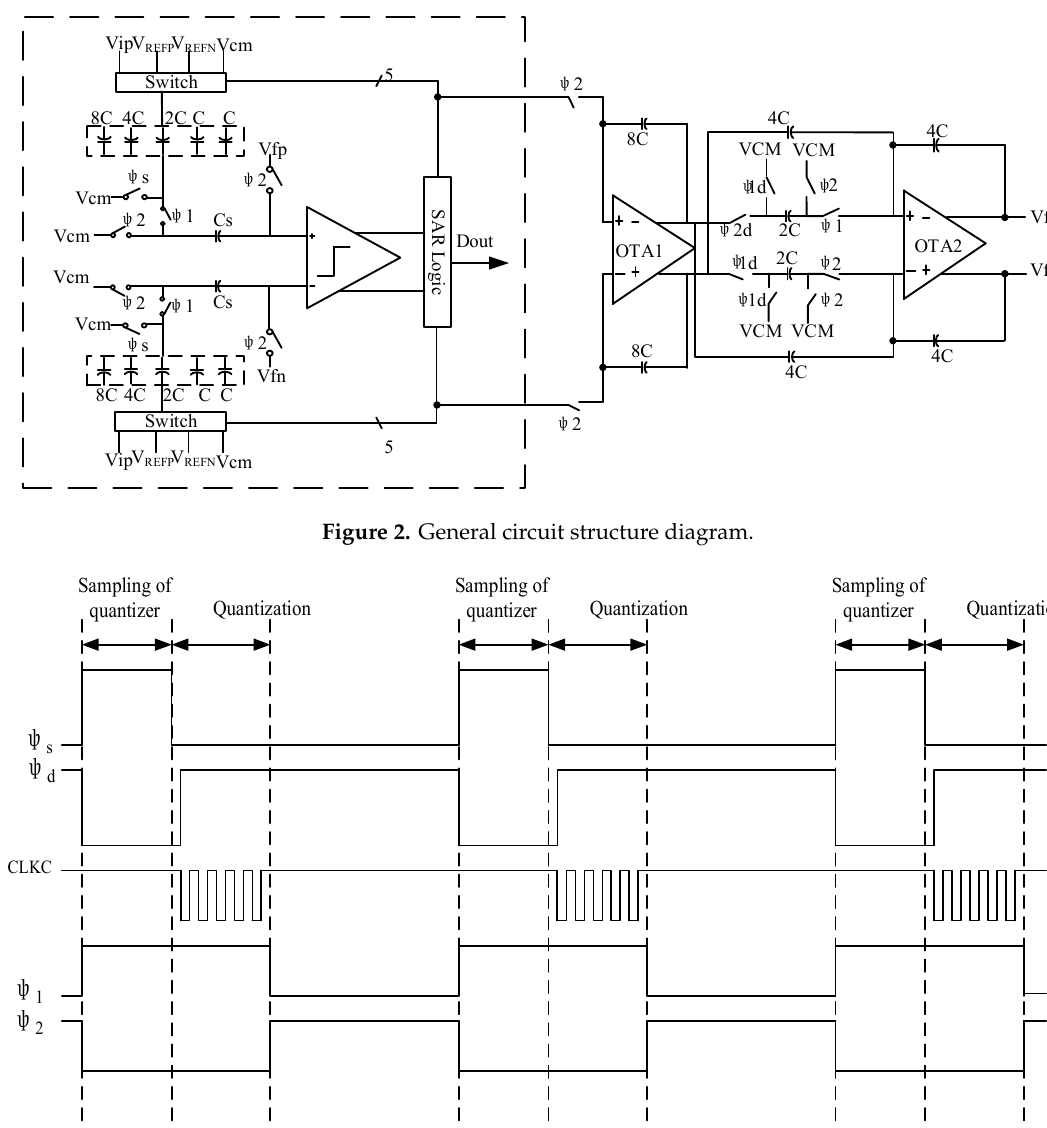
Figure 3. Modulator timing diagram. Where φ s is the quantization sampling clock, φ d is the quantization conversion clock and Clkc is the comparison clock of the successive approximation register (SAR) comparator [26].